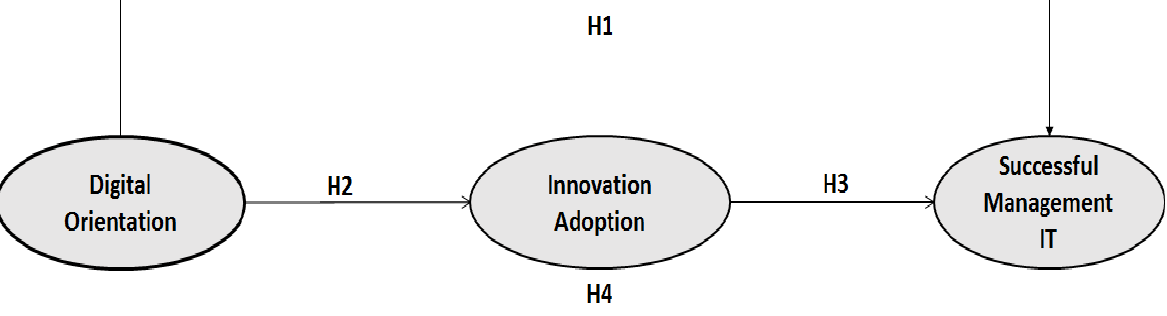
Figure 1. Digital Orientation on Successful Management of IT.